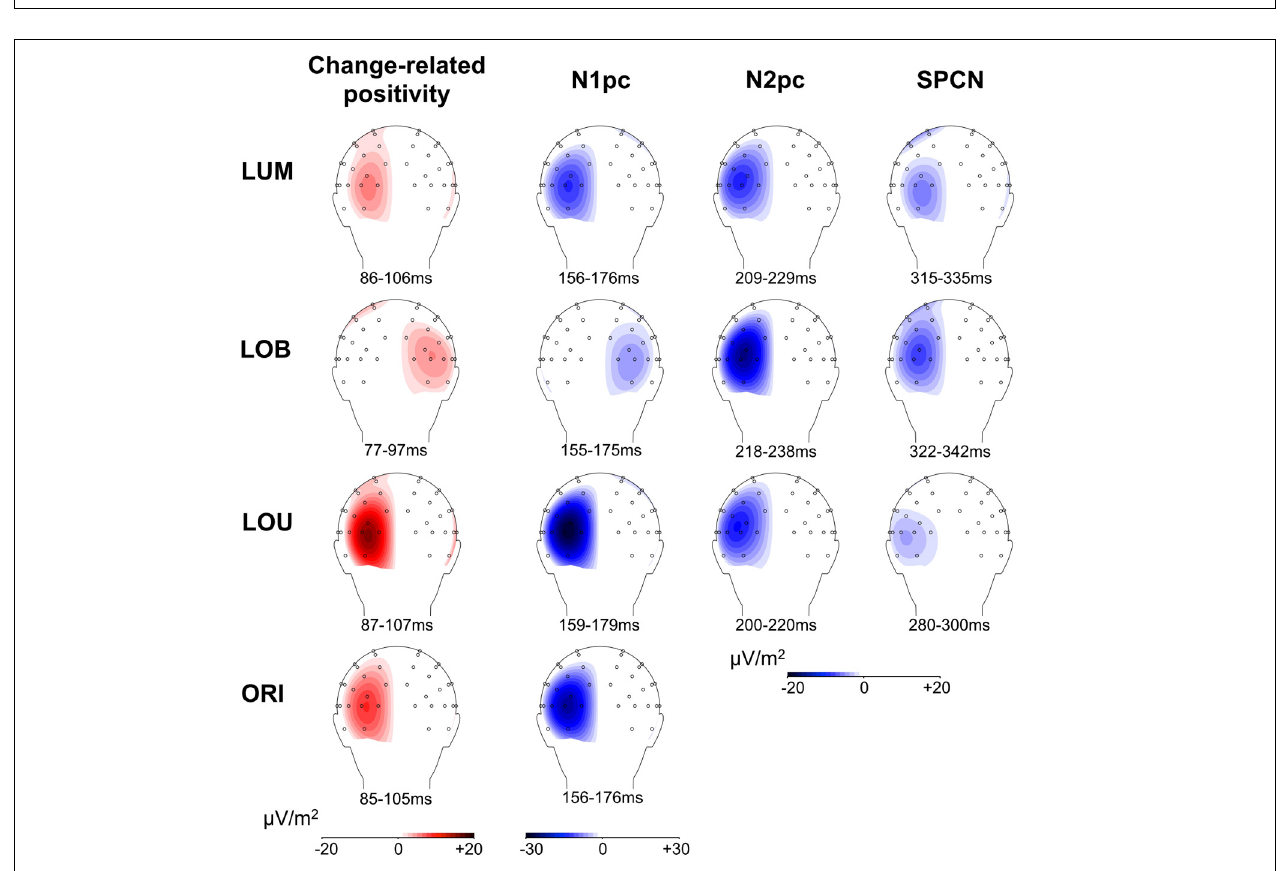
FIGURE 5 | Scalp topographies of posterior asymmetries for all change conditions. For N1pc, N2pc, and SPCN, the higher negativity contralateral to the relevant luminance change compared to the negativity contralateral to the irrelevant stimulus is plotted on the left hemisphere, while an asymmetry toward the irrelevant stimulus is plotted on the right hemisphere (see LOB